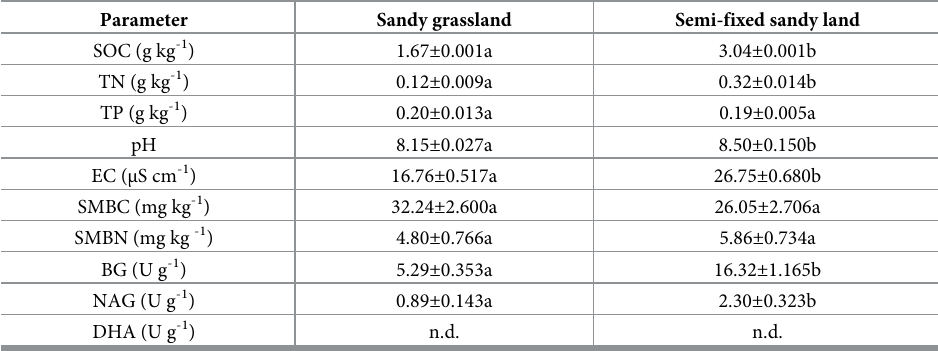
Table 1. The physical and chemical properties, initial values of soil microbial indices, and enzyme activity of the topsoil (to a depth of 20 cm) at the sandy grassland and semi-fixed sandy land sites. Parameter Sandy